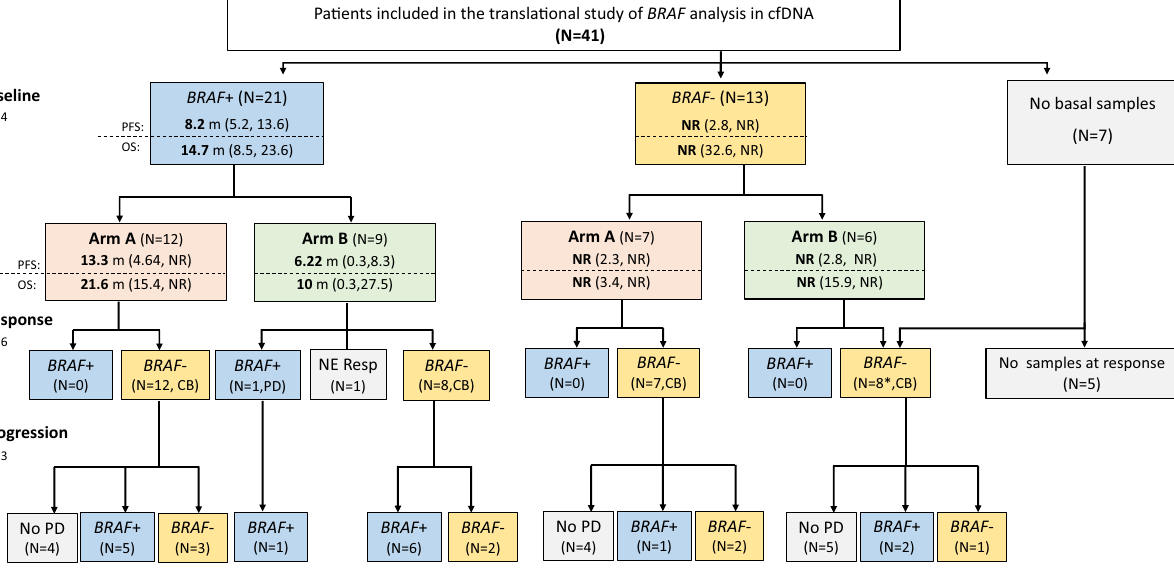
Fig. 3 Summary of BRAF cfDNA results. Arm A: Continuous arm; Arm B: Intermittent arm; CB: objective response or stable disease; m: months; NE resp: no response evaluation; No PD: patients without progression at data cut-off analysis; NR: no reached; PD: progression disease; *including two patients without basal